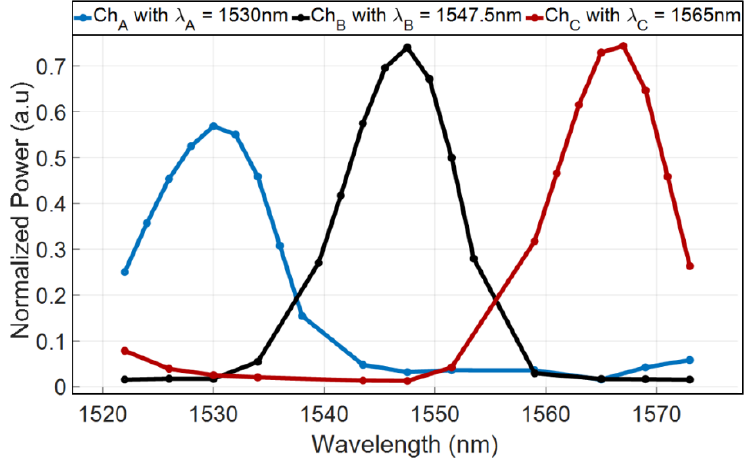
Figure 9. Optical spectrum around the